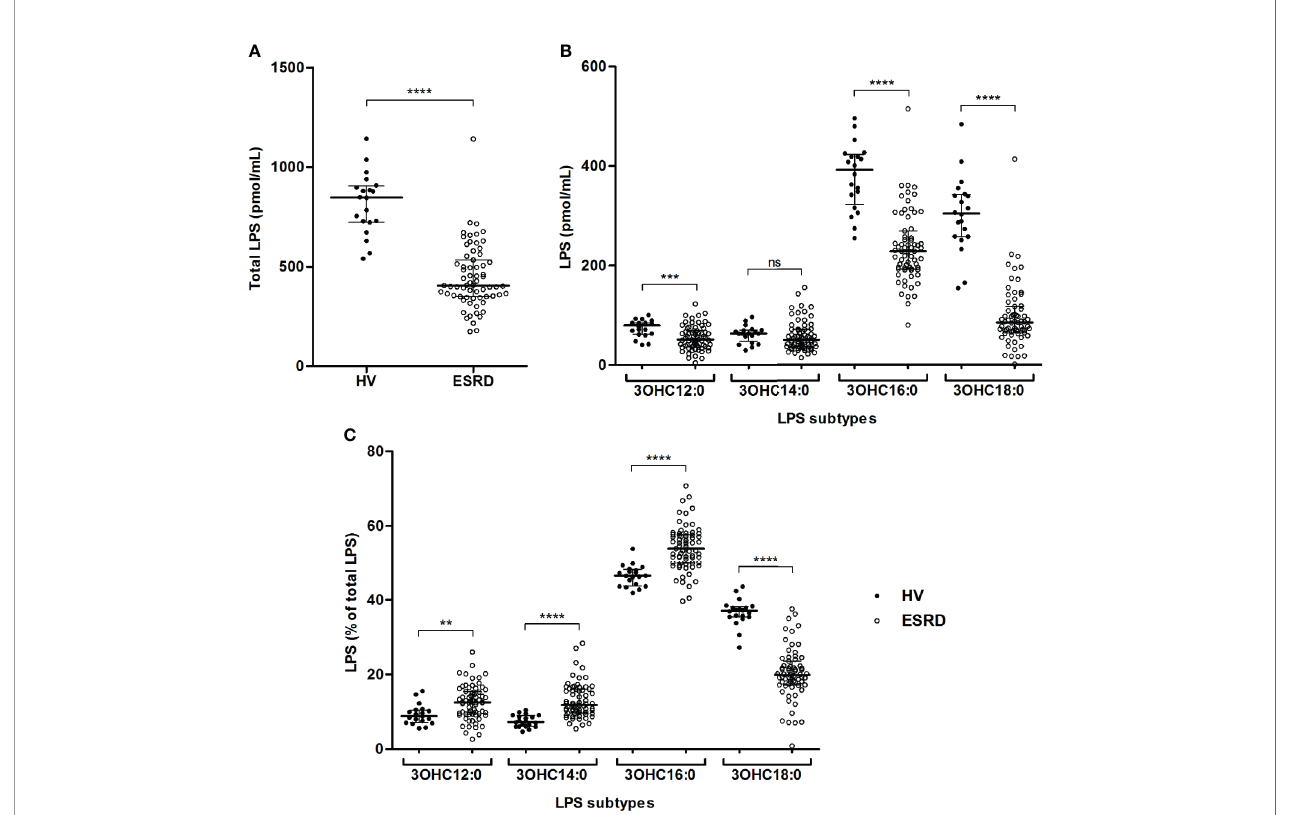
FIGURE 1 | Gut bacterial translocation in end-stage renal disease (ESRD) patients and healthy volunteers (HV). Comparison of total circulating LPS (A) , concentrations (B) and proportions (C) of circulating LPS subtypes between ESRD patients (n = 68) and healthy volunteers (n = 20). LPS quantities were measured in serum by HPLC/MS/MS method. LPS subtypes differed according to the length of lipid A carbon chains (3OHC12:0, 3OHC14:0, 3OHC16:0, 3OHC18:0) and their sum was considered as the total circulating LPS concentration used to determine LPS proportions. Bars and errors bars are expressed as median with interquartile range. Mann-Whitney U test of HV versus ESRD patient ’ s values, ** p < 0.01, *** p < 0.001, **** p < 0.0001, ns, not signi fi cant. HPLC/MS/MS, high performance liquid chromatography (HPLC) coupled with mass spectrometry (MS/MS); LPS,